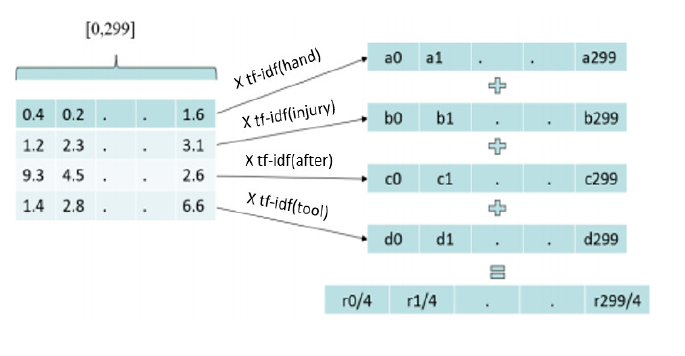
Figure 4. Vector representation of narratives.